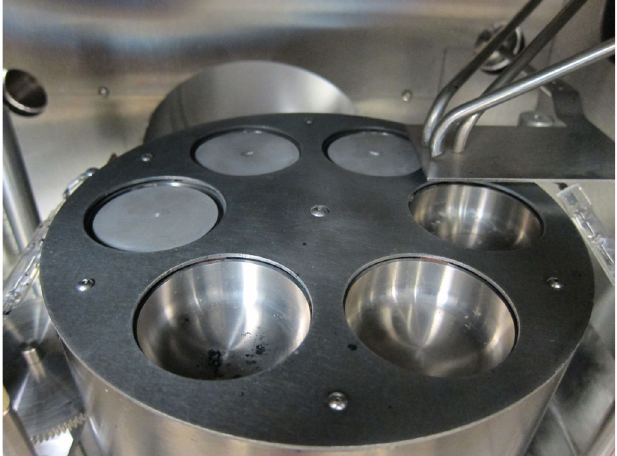
FIG. 2. The sample holder in the vacuum chamber of the laser treatment system.